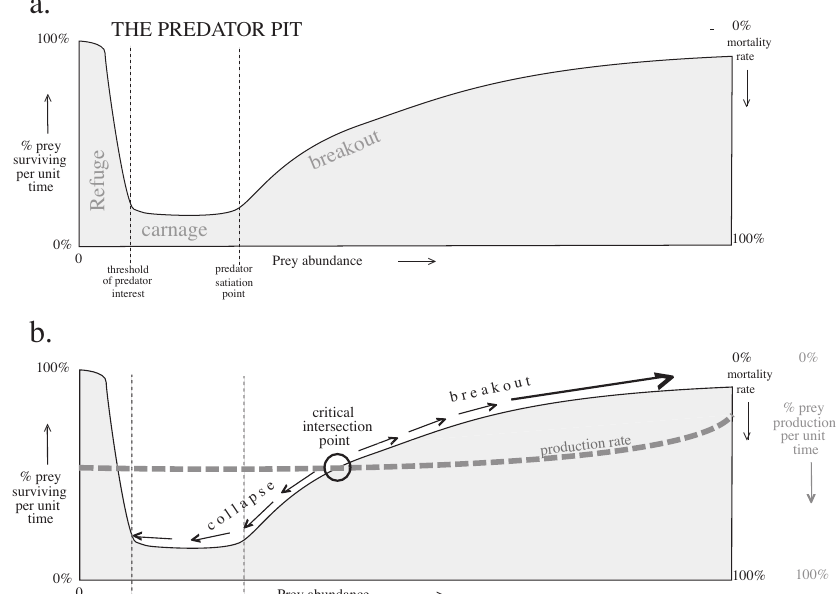
F IG . 7. – (a) Diagram of the predator pit function. Survival rate (plotted on the left ordinate) increases upwards. Mortality rate (plotted on the right ordinate) increases downwards. (b) Production rate curve (biomass produced per unit biomass per unit time — dashed grey curve) of the prey population superimposed on its predator pit function. A critical intersection point (circled), where the two curves intersect, marks the abundance level above which the rate of production exceeds the rate of predation mortality and the population increases (prey population achieves breakout) and below which the rate of predation mortality exceeds the rate of production (prey population collapses into the